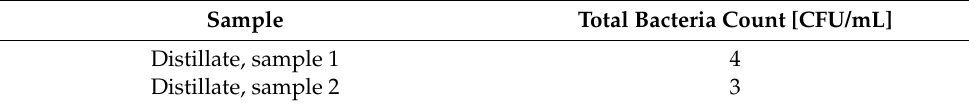
Table 9. Total bacteria count according to Ph. Eur.